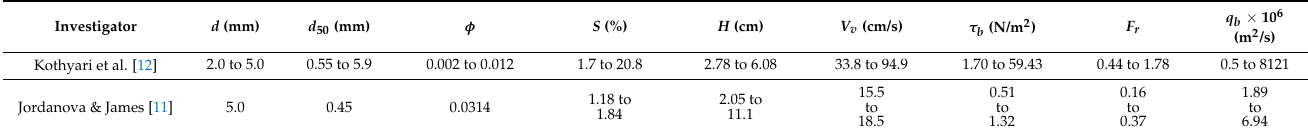
Table 3. Ranges of literature test data